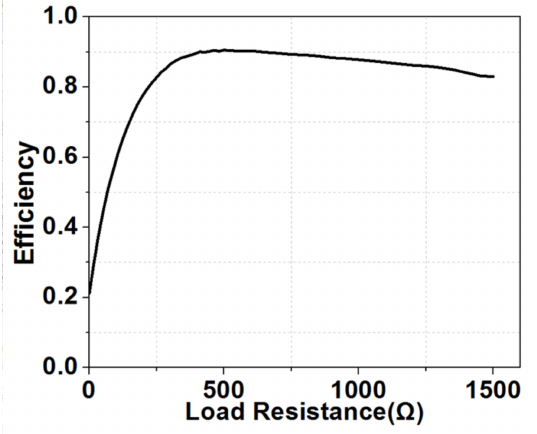
Figure 3. Calculated efficiency of the designed MS array for various values of load resistance at the operating frequency of 2.5